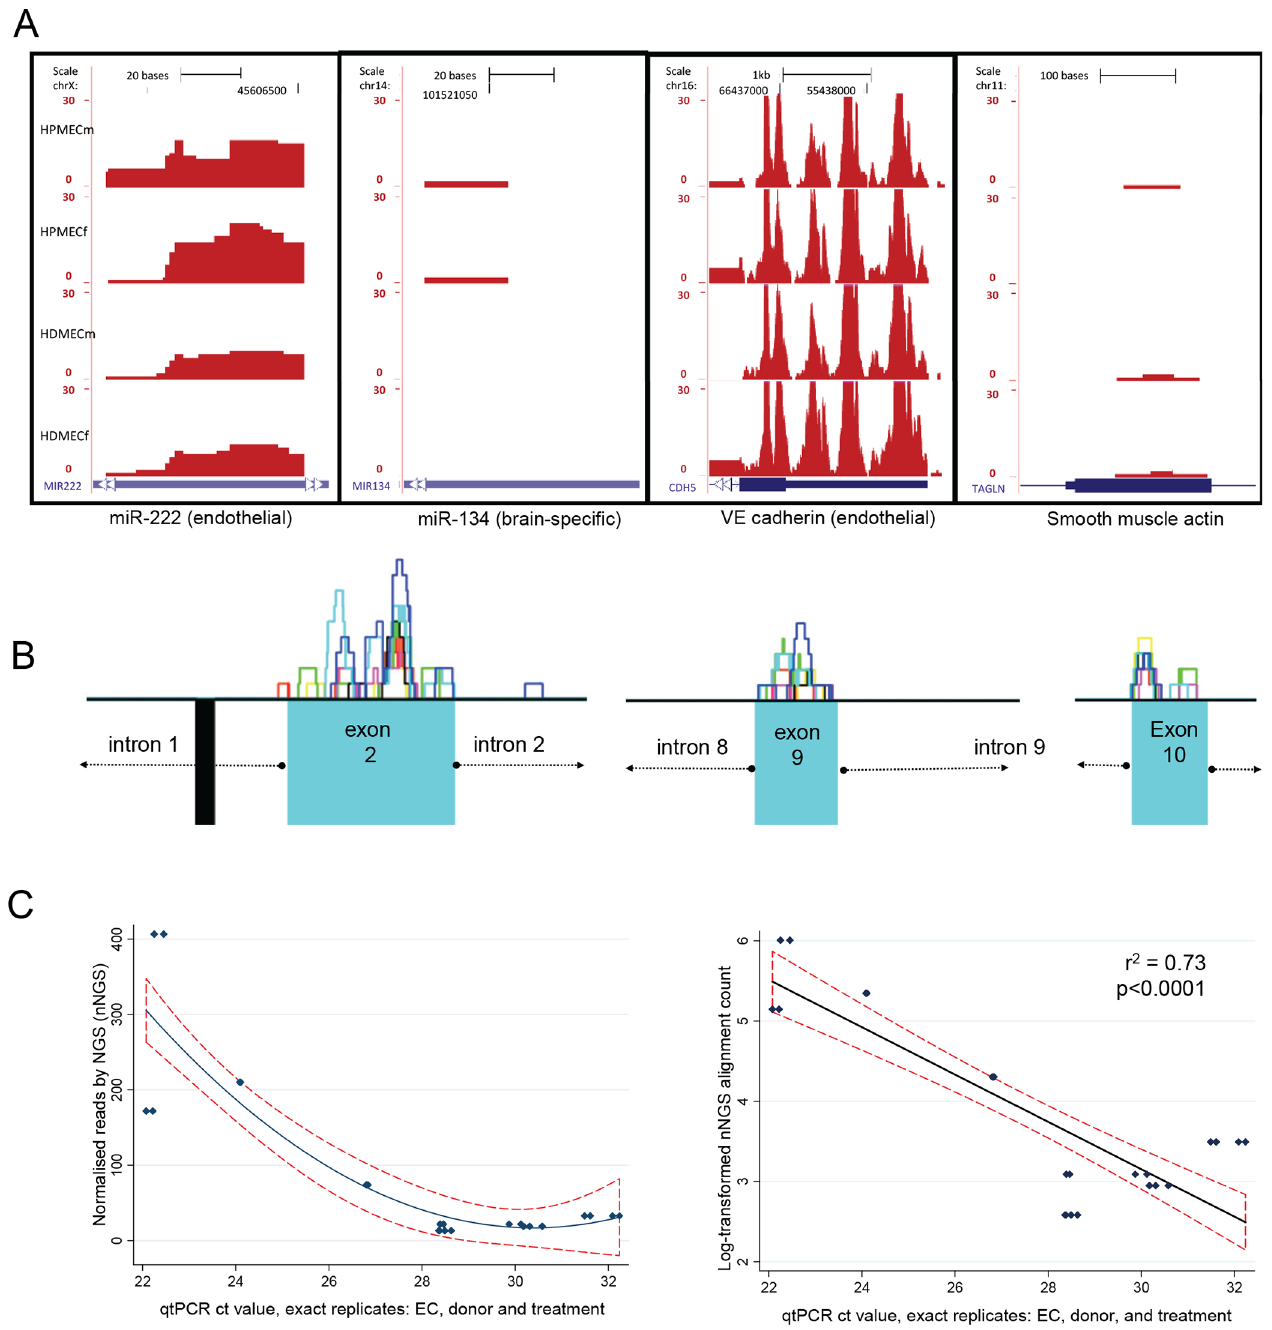
Fig 1. Methodological validations of RNASeq in human microvascular endothelial cells. A) Representative alignments from the four endothelial cell libraries described (HPMEC or HDMEC media (m) or iron (f)-treated), to pre-specified endothelial and non-endothelial specific micro(mi)RNAs and mRNAs. The 10 pre-specified miRNAs, and 10 pre-specified mRNAs, were either expressed strongly in endothelial cells, or recognized as non endothelial cell markers: the illustrated examples were representative of alignments to the other loci in the respective categories. Endothelial: miR-222, [23] and VE-cadherin (CDH5, [24], final exon illustrated). Non endothelial: miR-134, an example of a well known brain specific miRNA, [25] and SM22 α (TAGLN, smooth muscle actin, first exon). B) Representative coding strand exon alignments from all seven RNASeq libraries. Key: upper blocks with colored outlines: library-specific number of raw alignments, lower blue boxes: exons, lower black box: repeat element. Note the quasinormal alignments to the exons, and sharp exon/intron boundary definition. C) Linear regression and data plots of treatment-blinded miRNA alignments (log-transformed) and qt-PCR validations for all experiments performed with replicate treatment of replicate cells from identical donors. (Ct value is the cycle threshold when fluorescence exceeds background). For the 122 datasets from the same treatments in the same EC type but from different donors, the correlation r 2 was 0.22, p < 0.0001 (data not shown).